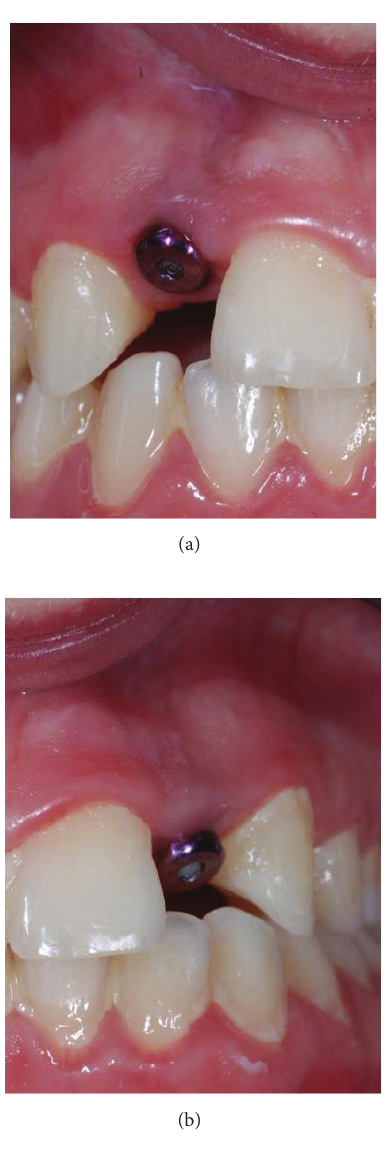
Figure 14: Clinical control after three months.